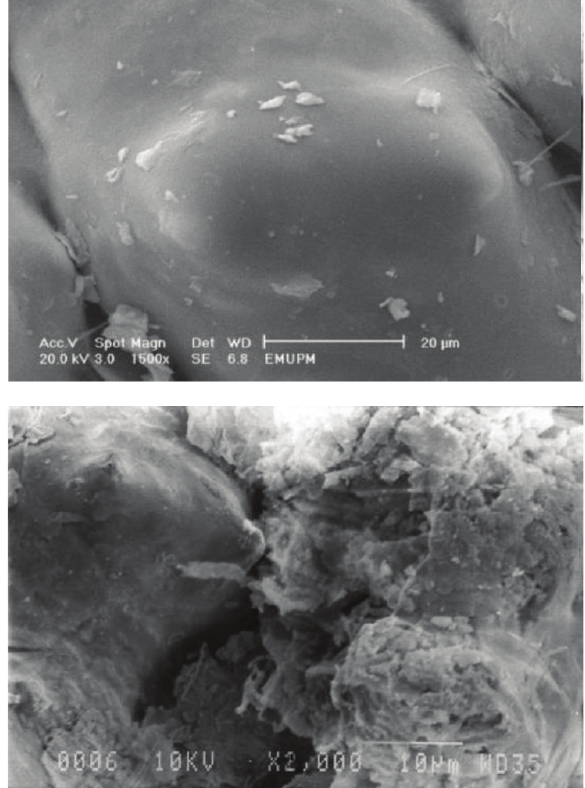
Fig. 1 – SEM of rice husk, left: raw rice husk, right: rice husk